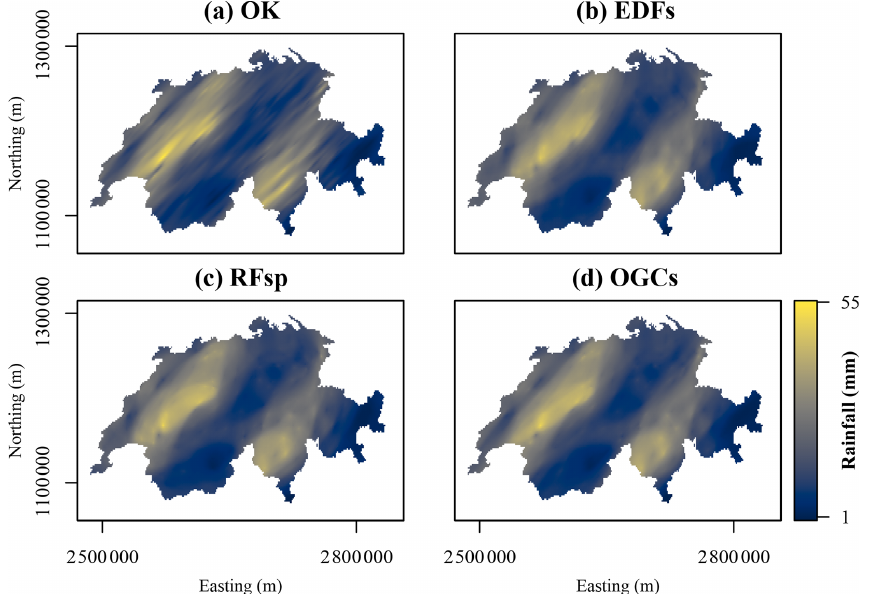
Figure 11. Maps of rainfall on 8 May 1986 in Switzerland predicted with each method. Northing and easting are coordinates according to the Swiss coordinate system LV95. (a) Ordinary kriging (OK), (b) Euclidean distance fields (EDFs), (c) distances to observations (RFsp), and (d) oblique geographic coordinates